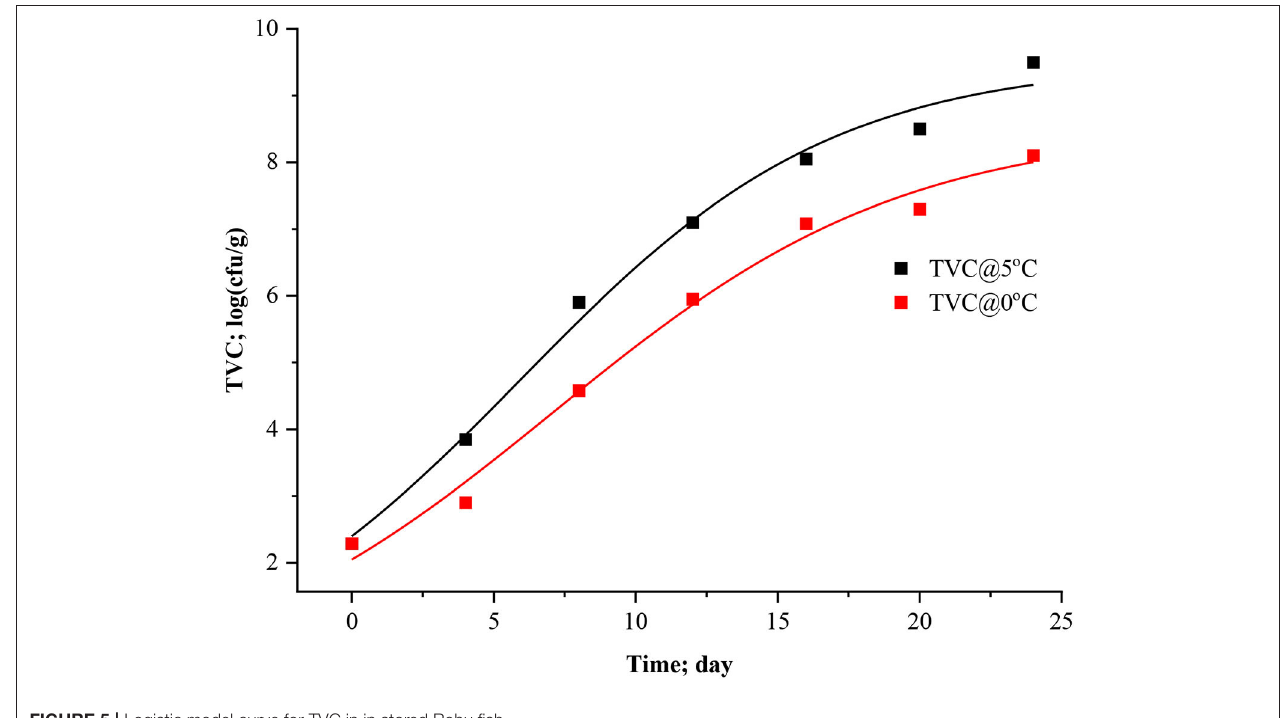
FIGURE 5 | Logistic model curve for TVC in in stored Rohu fish.